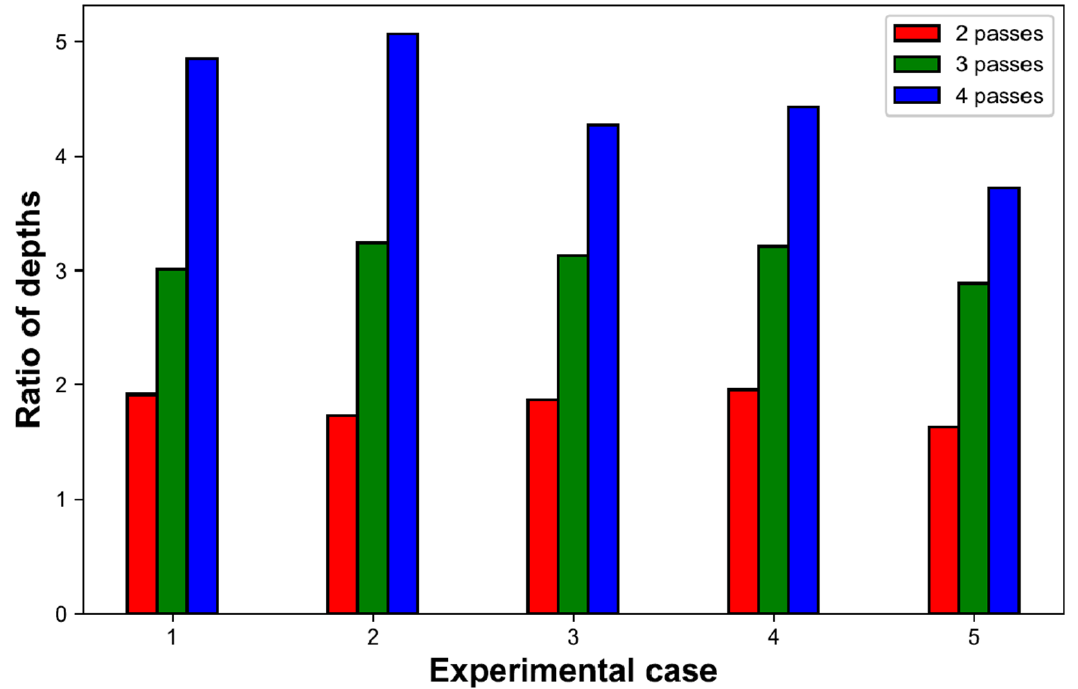
Figure 4. Ratio of depth obtained with 2, 3, or 4 passes, with respect to the depth of the first pass under various experimental conditions.